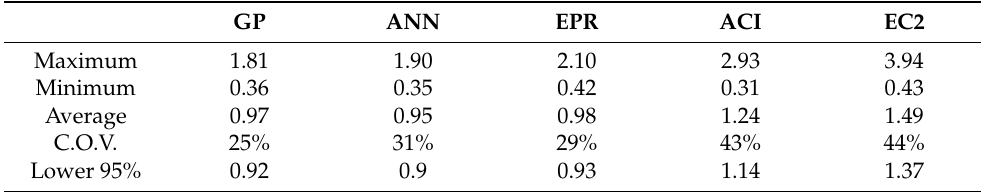
Table 6. Statistical methods for SF using various